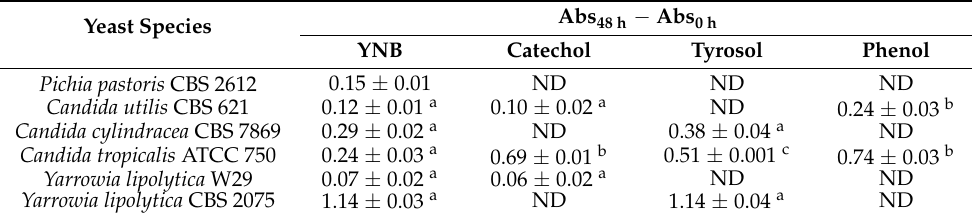
Table 3. Cellular growth of several yeast strains in liquid phenolic compound-based media and YNB (control) evaluated by the difference between the optical density ( λ = 600 nm) at the end (48 h) and beginning (0 h) of the experiments. Data are the average ± standard deviation of three independent replicates. Values followed by the same letter in each row do not present statistically significant differences ( p ≤